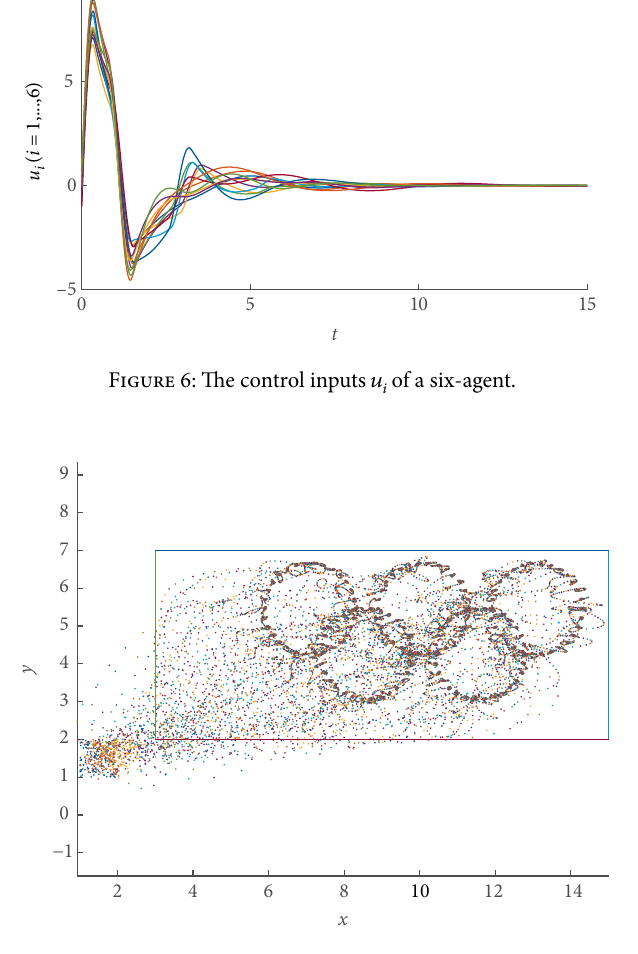
Figure 7: The motion trajectory of a 155-agent.